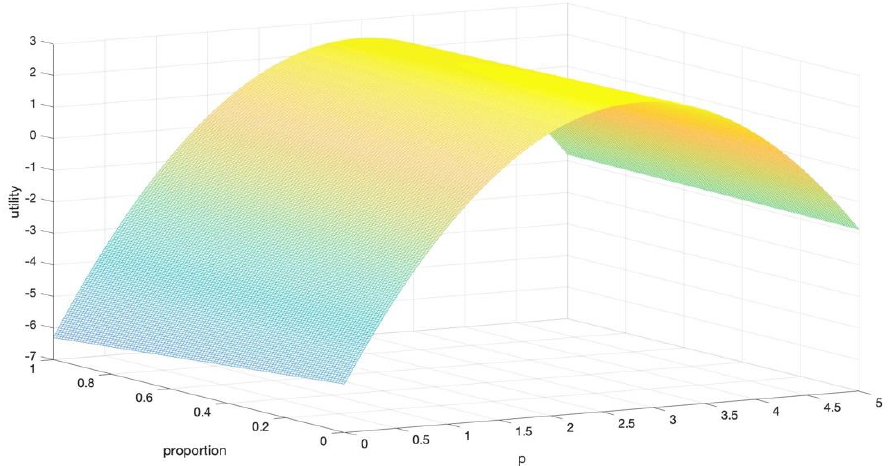
Figure 4. The impact of the retail price and distribution ratio on retailer profits.